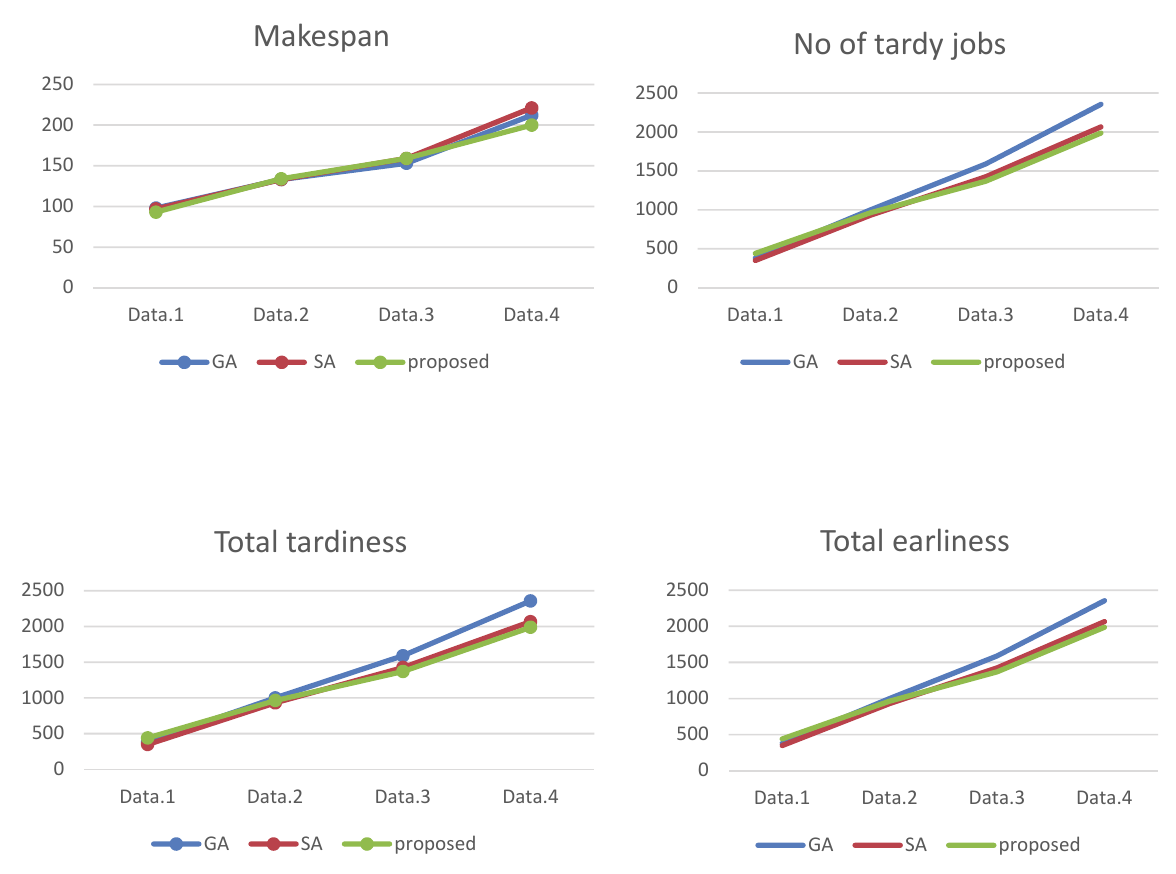
Fig. 10. Obtained Makespan, No of tardy jobs, Total earliness and Total tardiness for each algorithm and each